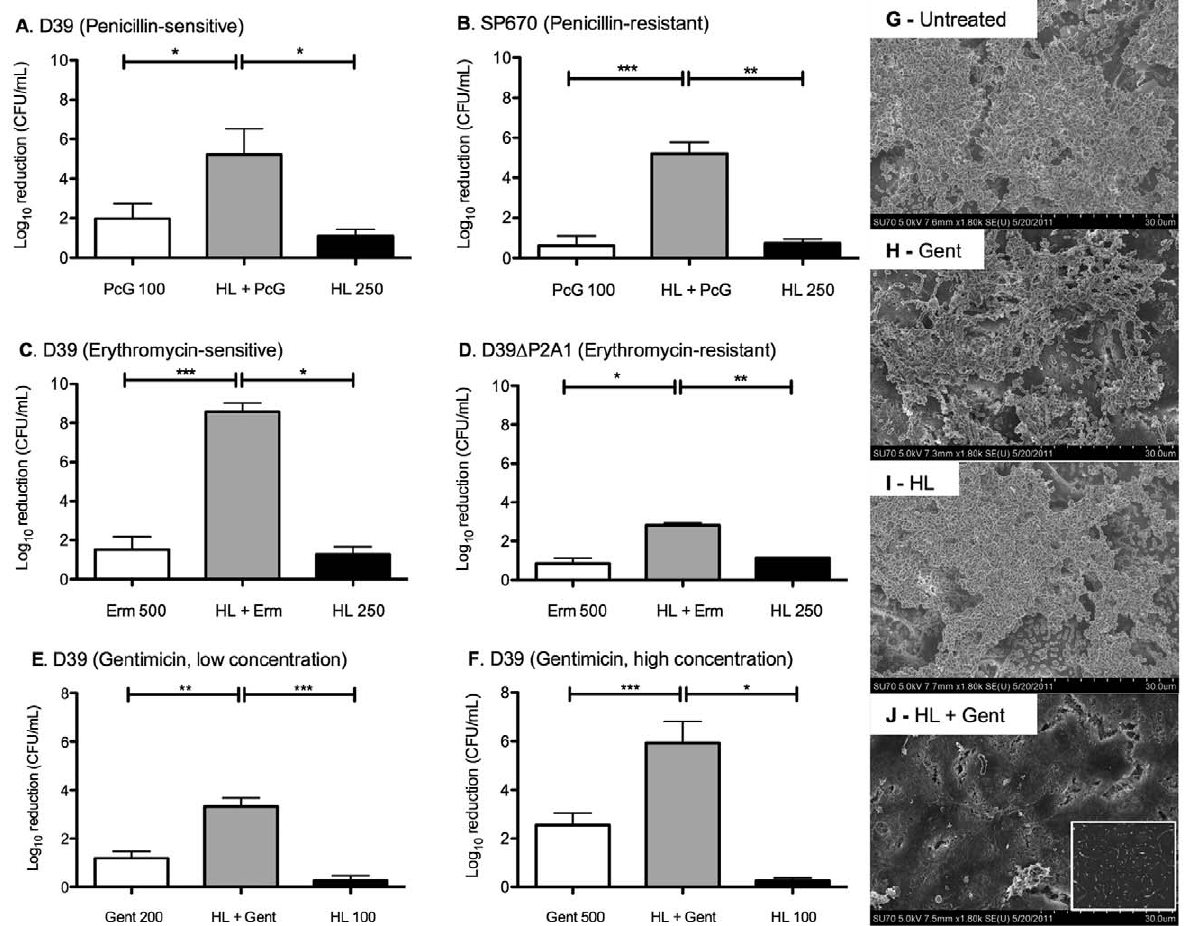
Figure 3. The effect of HAMLET/antibiotic combination treatment on in vitro biofilm viability. The activity of penicillin G (100 m g/mL), HAMLET (250 m g/mL), or the combination of both agents were tested on in vitro biofilms of the penicillin-sensitive strain D39 (A) or the penicillin- resistant strain SP670 (B) formed over a prefixed epithelium of NCI-H292 cells and were tested by determining the bacterial death (in log 10 ) after culturing bacterial dilutions overnight on blood agar. Similarly, the activity of erythromycin (250 m g/mL), HAMLET (250 m g/mL), or the combination of both agents on in vitro biofilms of the erythromycin-sensitive strain D39 (C) or the erythromycin-resistant strain D39-P2A1 (D) were tested in a similar fashion as was the activity of 200 m g/ml gentamicin (E) or 500 m g/ml gentamicin (F) alone or in combination with 100 m g/ml HAMLET (100 m